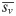
Least squares linear regressions showing the relationship between volume backscattering coefficients (sv¯) and mean school depth for the 36 matched schools insonified by the recreational fish-finder (RFF) and the scientific echosounder (SES).Shaded areas denote 95% confidence intervals.